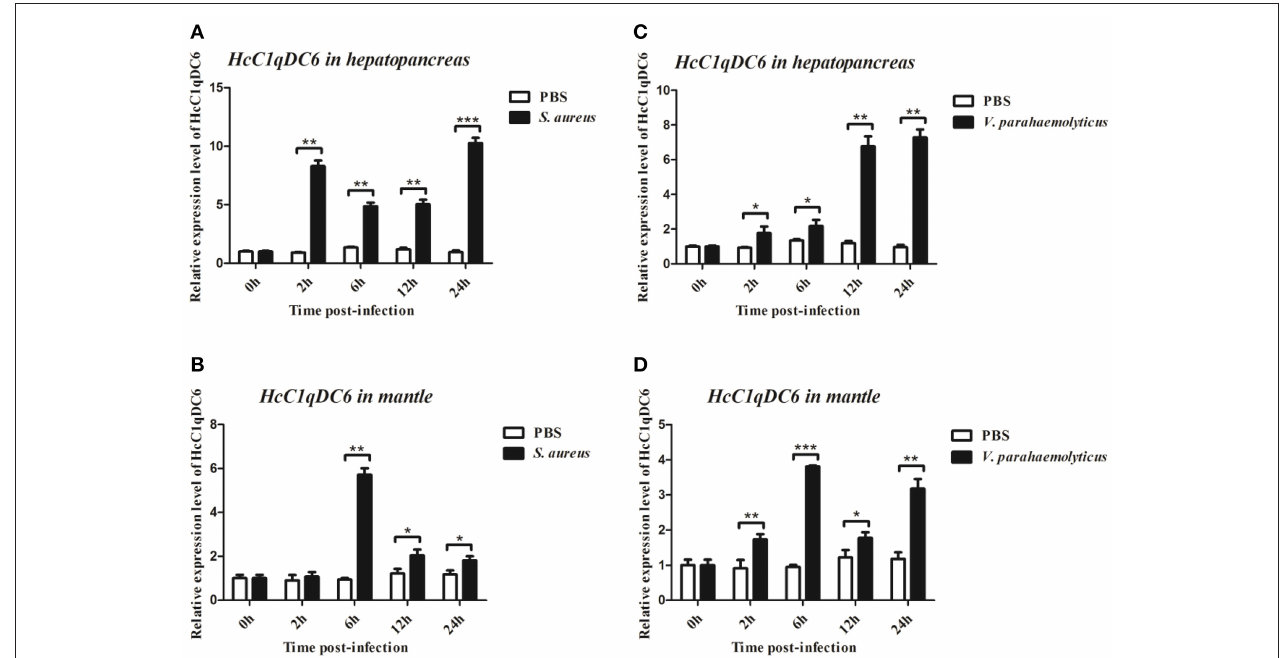
FIGURE 5 | Time course analysis of HcC1qDC6 expression pattern in the hepatopancreas and mantles of H. cumingii under S. aureus or V. parahaemolyticus challenge at 2, 6, 12, and 24 h. Asterisks indicate significant differences (* P < 0.05, ** P < 0.01, *** P < 0.001) when compared with that of the control.